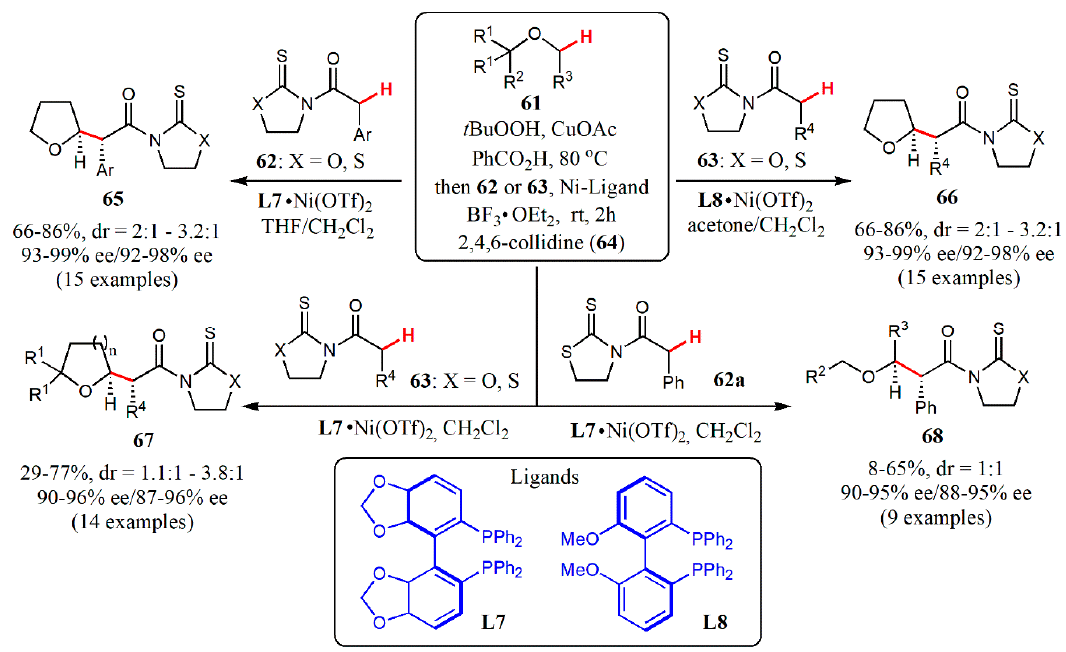
Figure 19. Enantioselective CDC of saturated ethers with carboxylic acid derivatives.